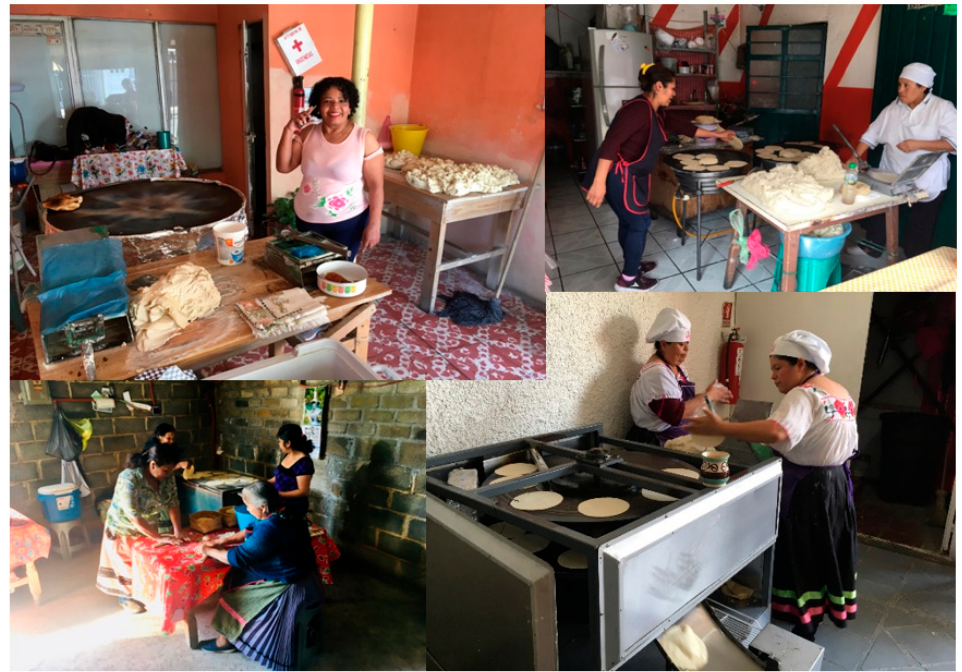
Figure 2. Handmade comal tortilla establishment in urban, peri-urban, and rural areas. Source: Authors.